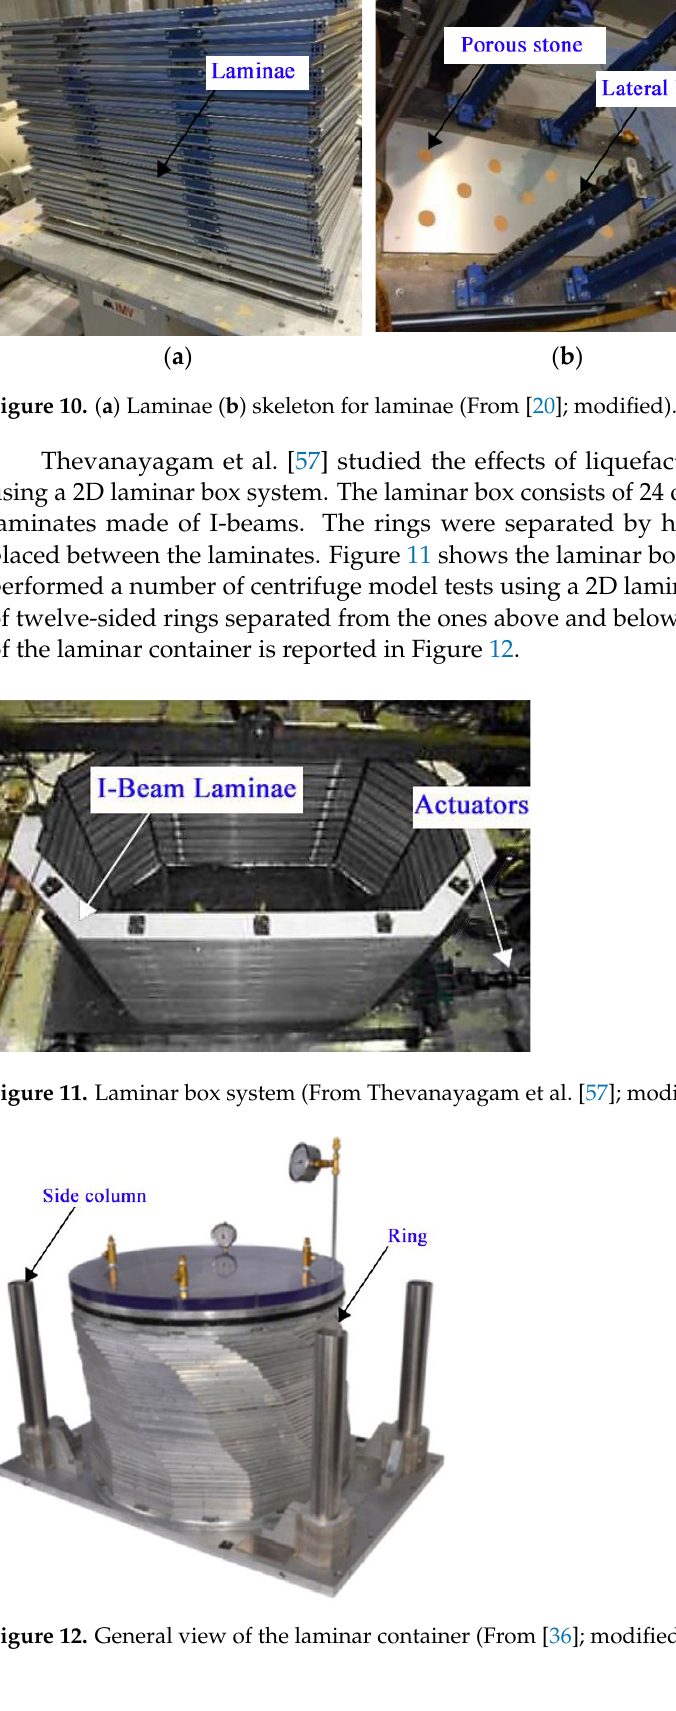
Figure 12. General view of the laminar container (From [36]; modified).